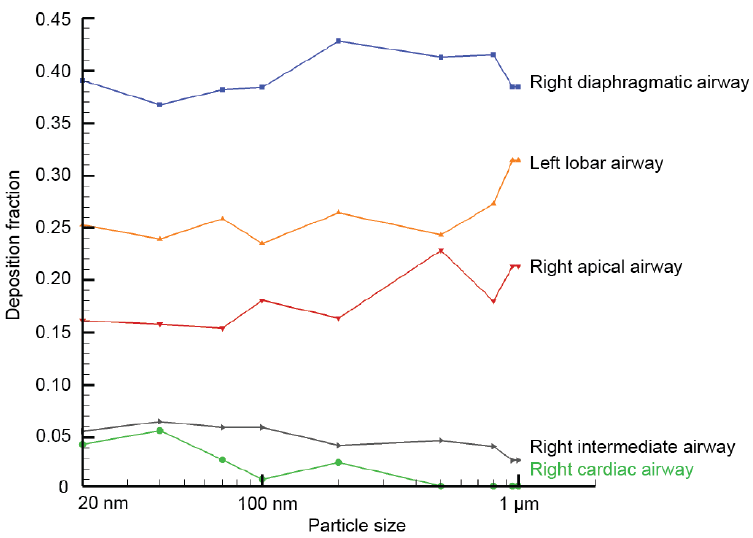
Figure 5. Compartment deposition fraction of the overall deposition in the central airway.